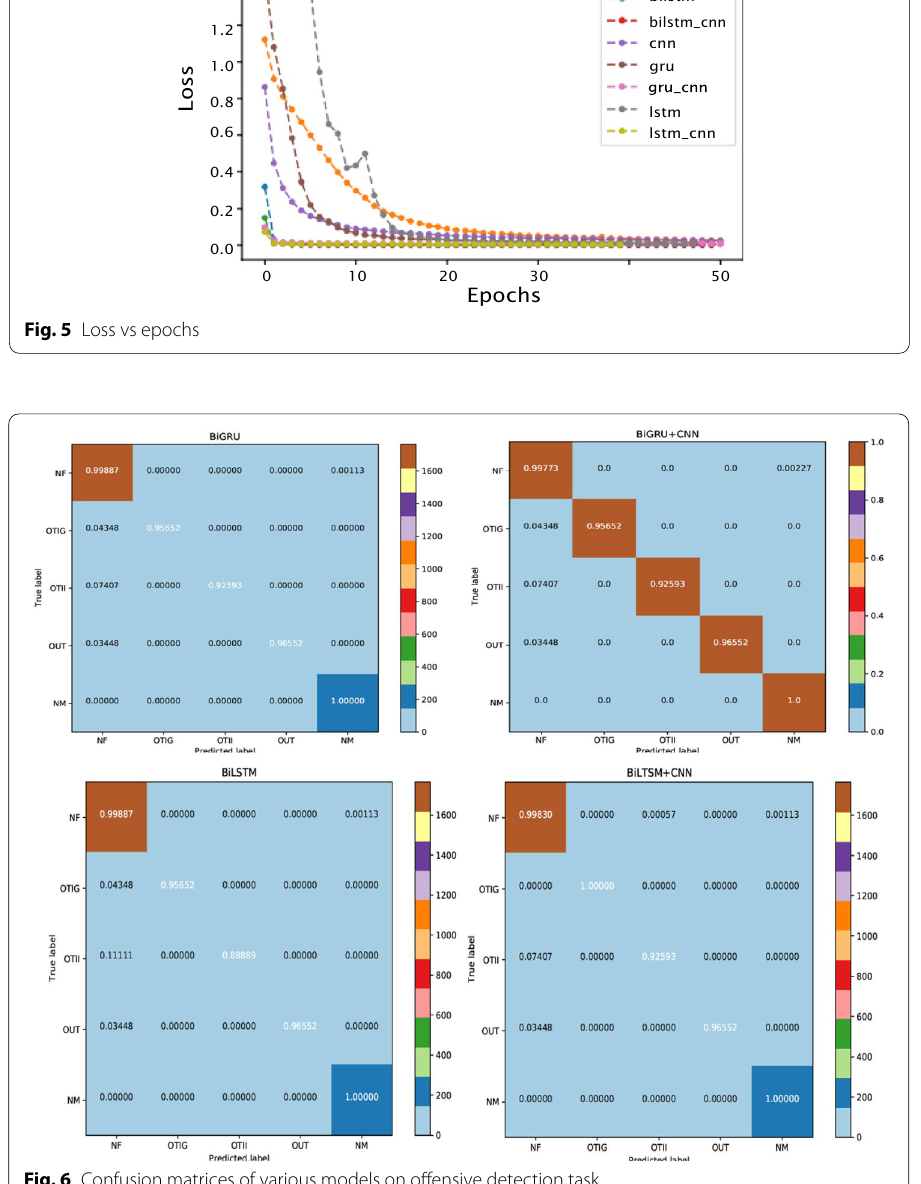
Fig. 6 Confusion matrices of various models on offensive detection task